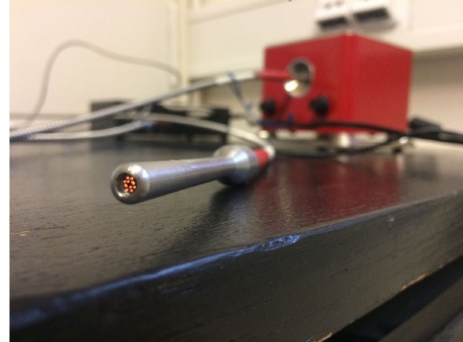
Figure 2. Probe on the end of optical fiber.